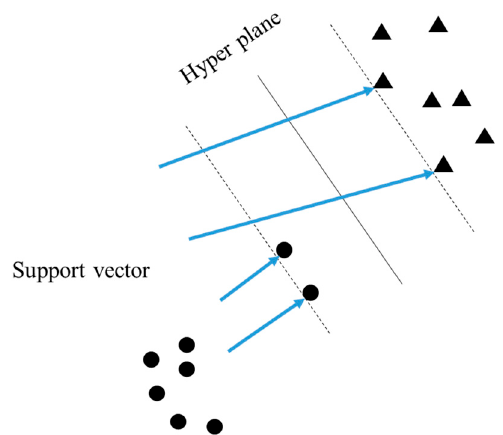
Figure 7. The graphical depiction of the mechanism of an SVM.